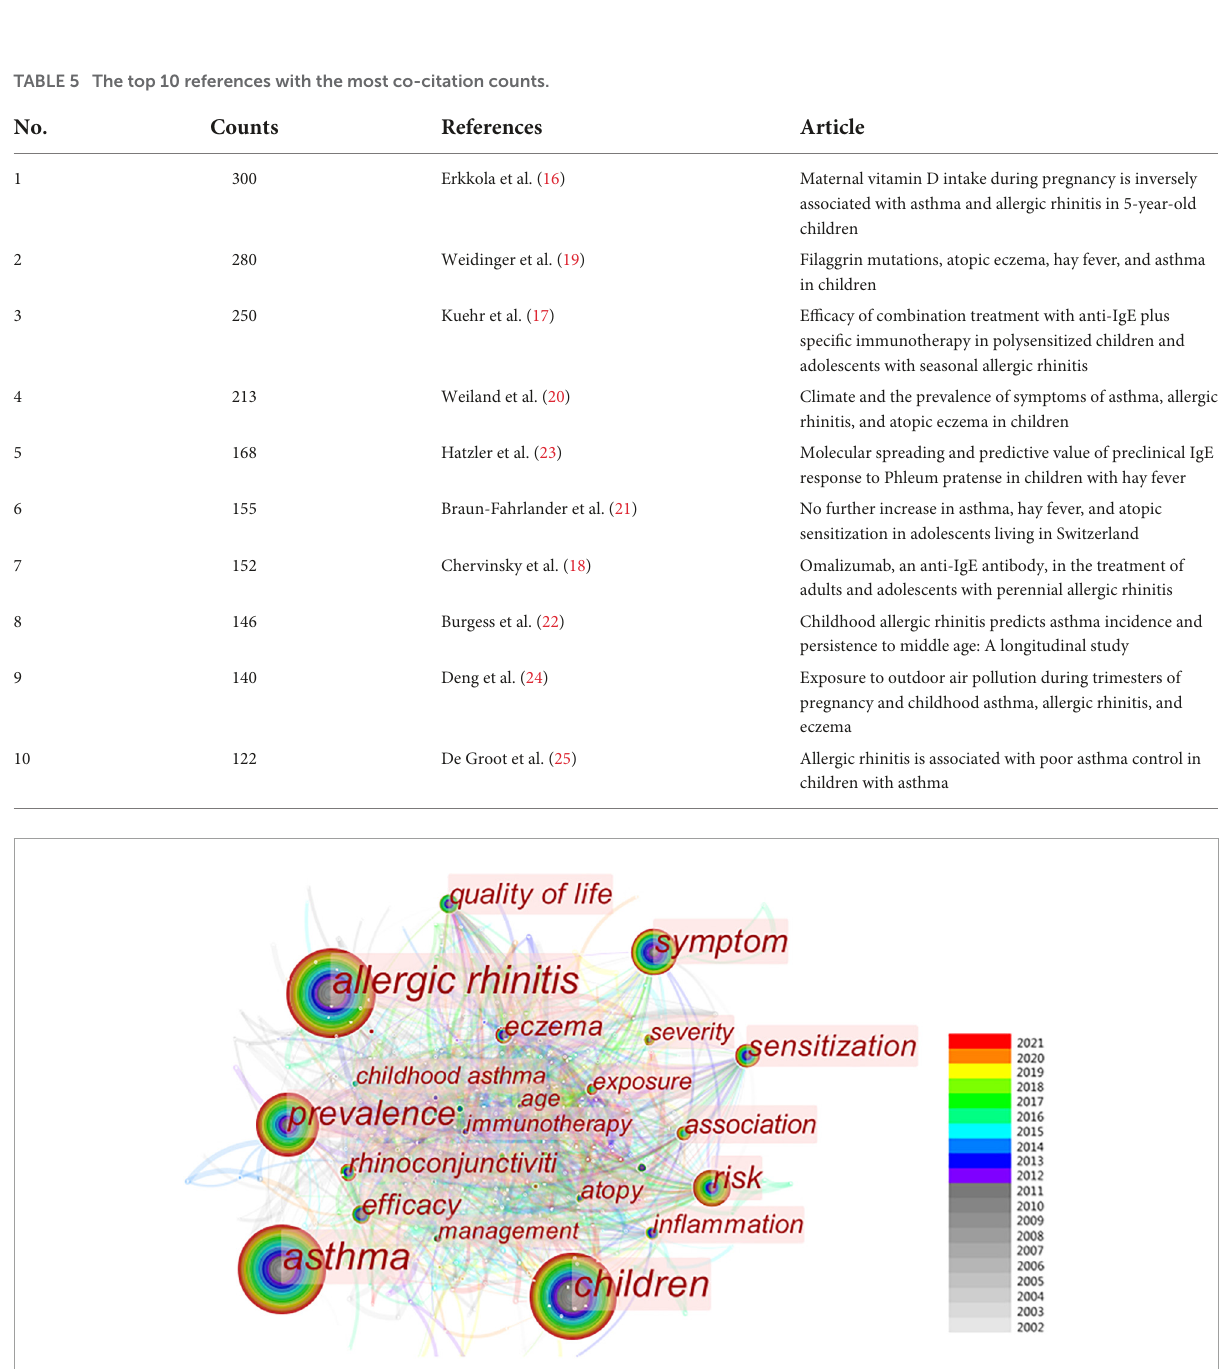
the burst strength and timespan varied. The burst keyword with the highest strength was “nasal” (strength = 3.71), which lasted for five consecutive years from 2006 to 2011, followed by “corticosteroid” (strength = 3.6, 2002–2009), and “immunotherapy” (strength = 3.54, 2012–2016). The burst keyword “severity” (strength = 3.05) has received